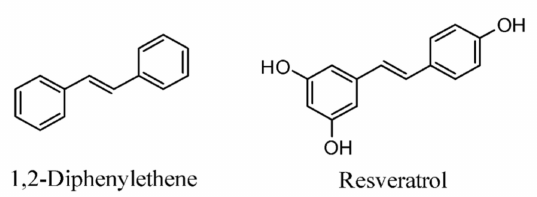
Figure 2. Chemical structures of stilbenes.